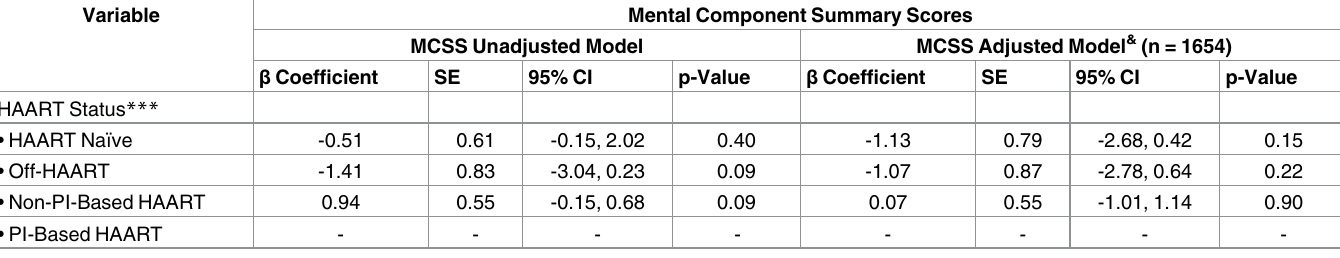
Table 6. Unadjusted and adjusted MCS scores for HAART with PI-HAART as the referent category.